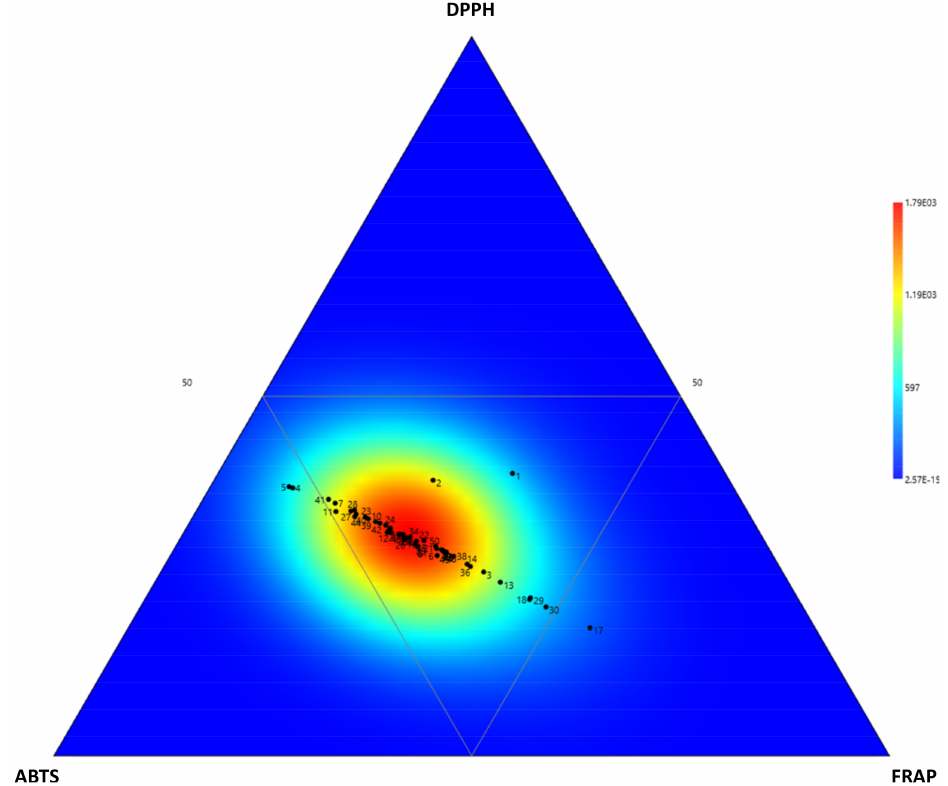
Figure 4. Ternary plot showing the contribution of the relative in vitro assay to the antioxidant activity of the 50 Fabaceae populations from various floristic regions from